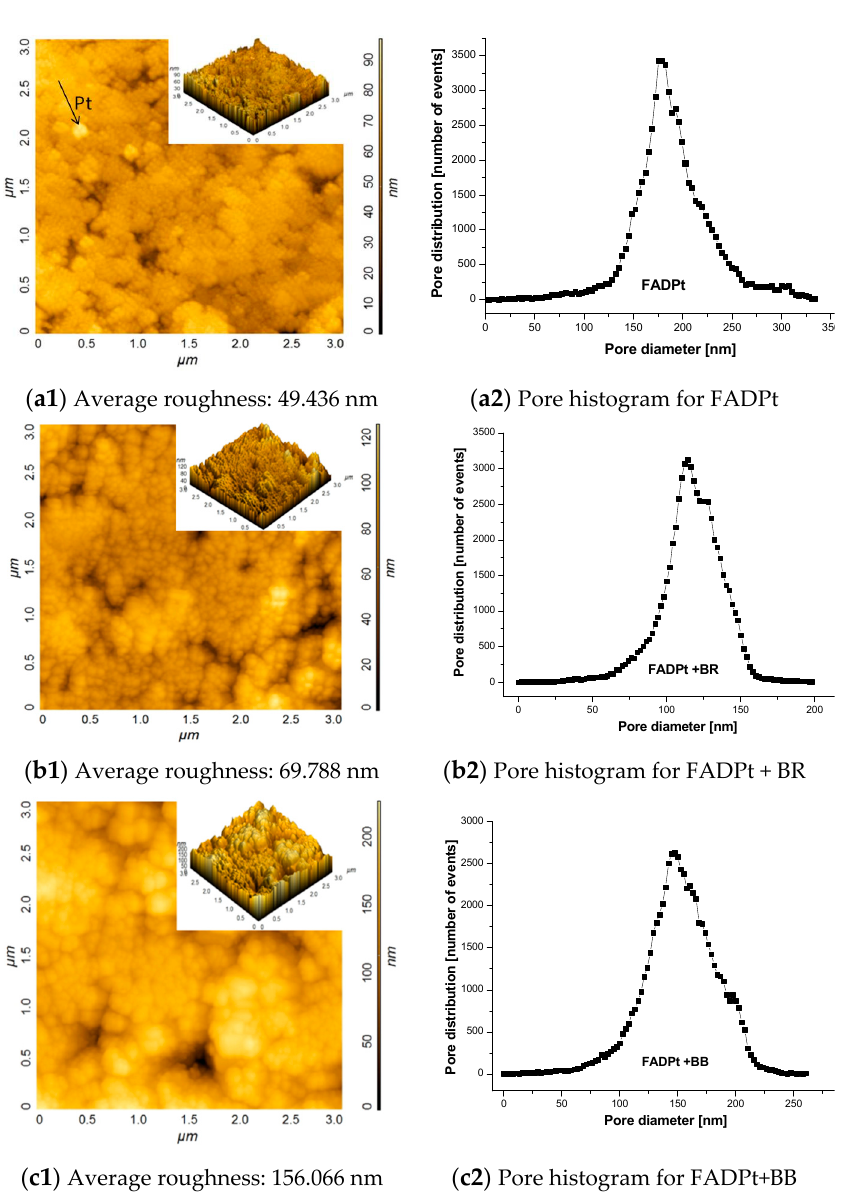
Figure 4. AFM topography, average roughness and pore distribution before and after adsorp- tion/photocatalysis for: ( a ) FADPt; ( b ) FADPt loaded with BR; ( c ) FADPt loaded with